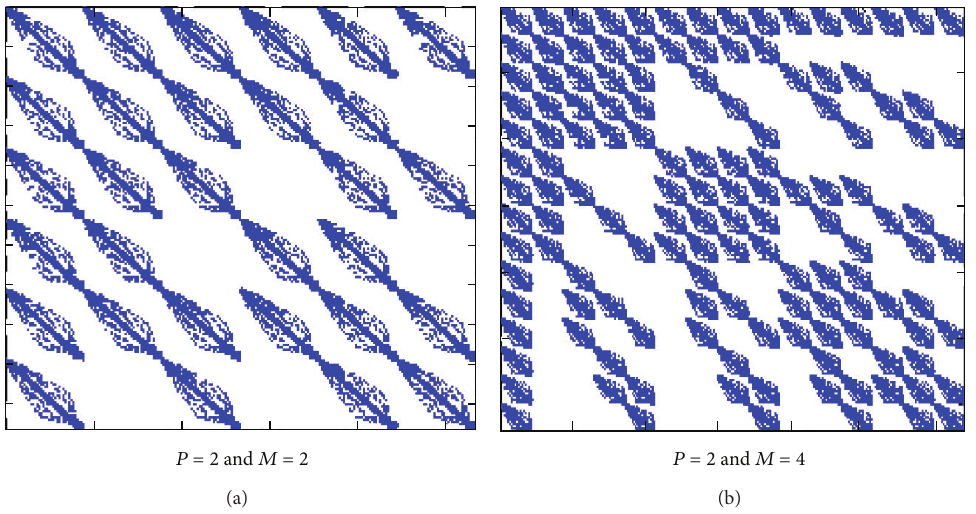
Figure 2: Sparsity pattern for the global matrix, cavity 500 cells.